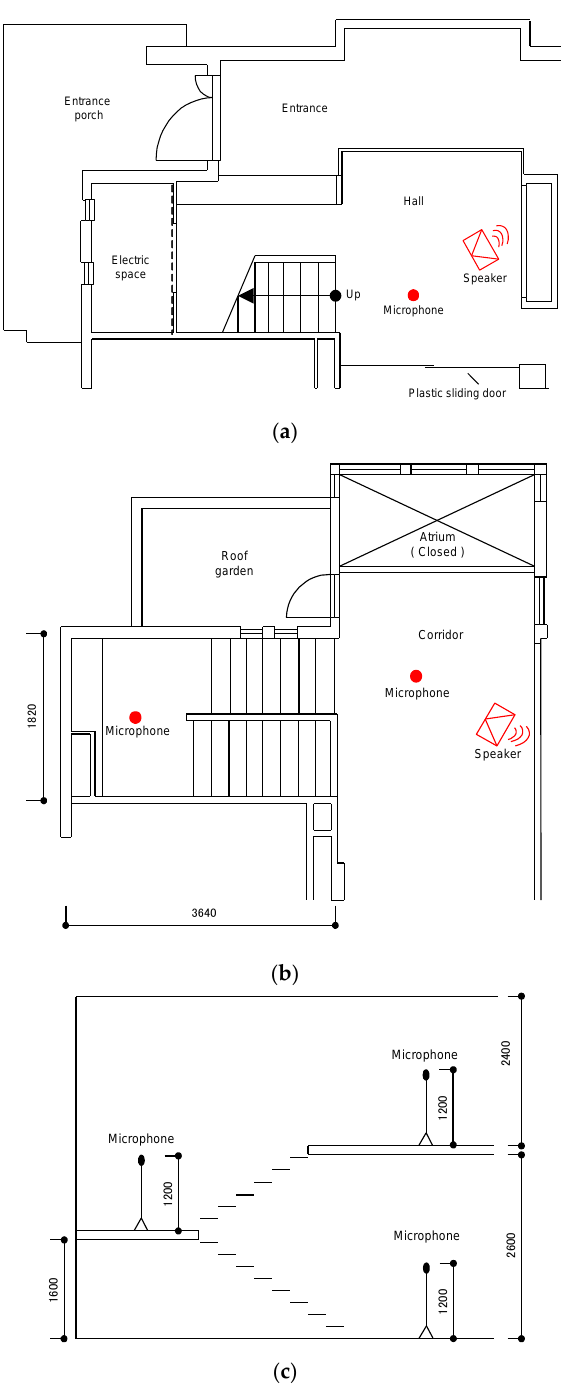
Figure 4. Plan of the stairwell used in the experiment. ( a ) First floor plan, sound source position and measurement position; ( b ) Second floor plan, sound source position and measurement position. ( c ) Sectional view of stairwell and microphone height.